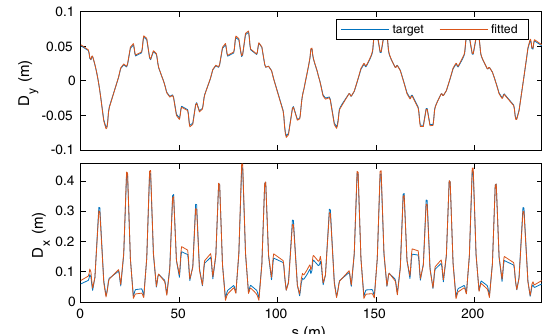
FIG. 8. Comparison of fitted fractional quadrupole gradient changes, Δ K=K (top), and skew quadrupole gradients (bottom) with respect to the expected values.